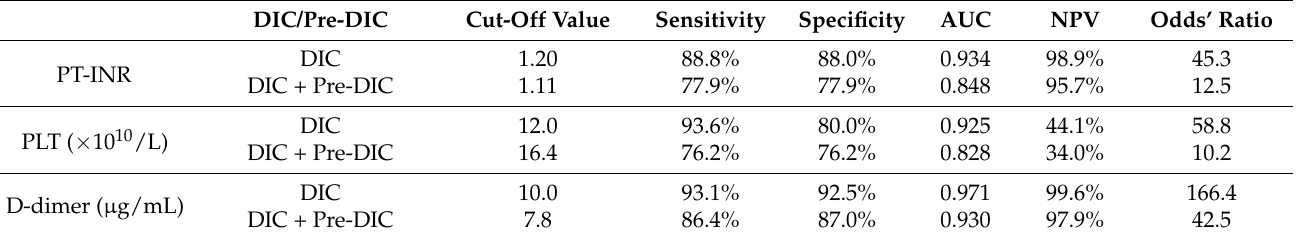
Table 3. ROC analysis of PT-INR, platelet counts, and D-dimer for diagnosing DIC or pre-DIC vs. non-DIC.